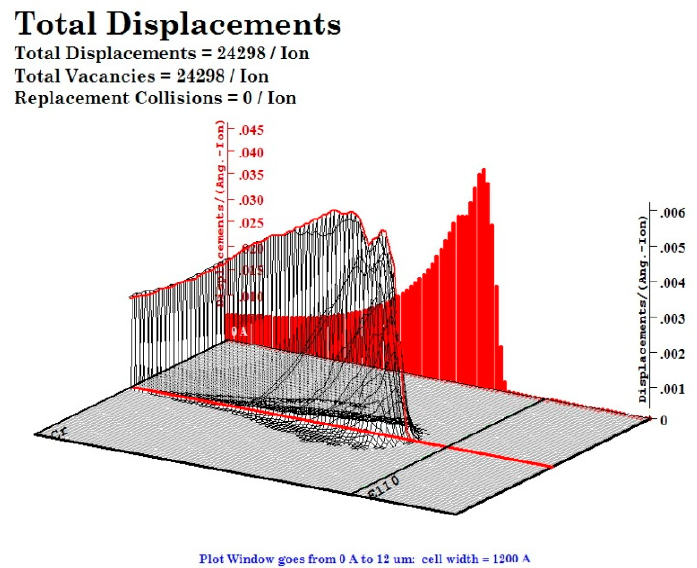
Figure 9. Damage caused by 120 MeV Ru in E110 alloy, coated with 9 µm thin film of Cr. The maximum anticipated recoil energy for molybdenum (Mo) produced during the fission of nuclear fuel is about 120 MeV. This high energetic particle is expected to induce a total damage in the cladding material (E110) ~ 26,826 vacancies/ion. This damage extends to depths of more than 10 µm inside the cladding material (Figure 10). Figure 11 shows the same damage calculations but for a coated cladding with a 9 µm thin film of metallic chromium. In this case, calculations show that the fuel cladding material will remain intact as the energetic Mo will be stopped inside the Cr with a relatively shorter range, the displacement damage created will be less as well.